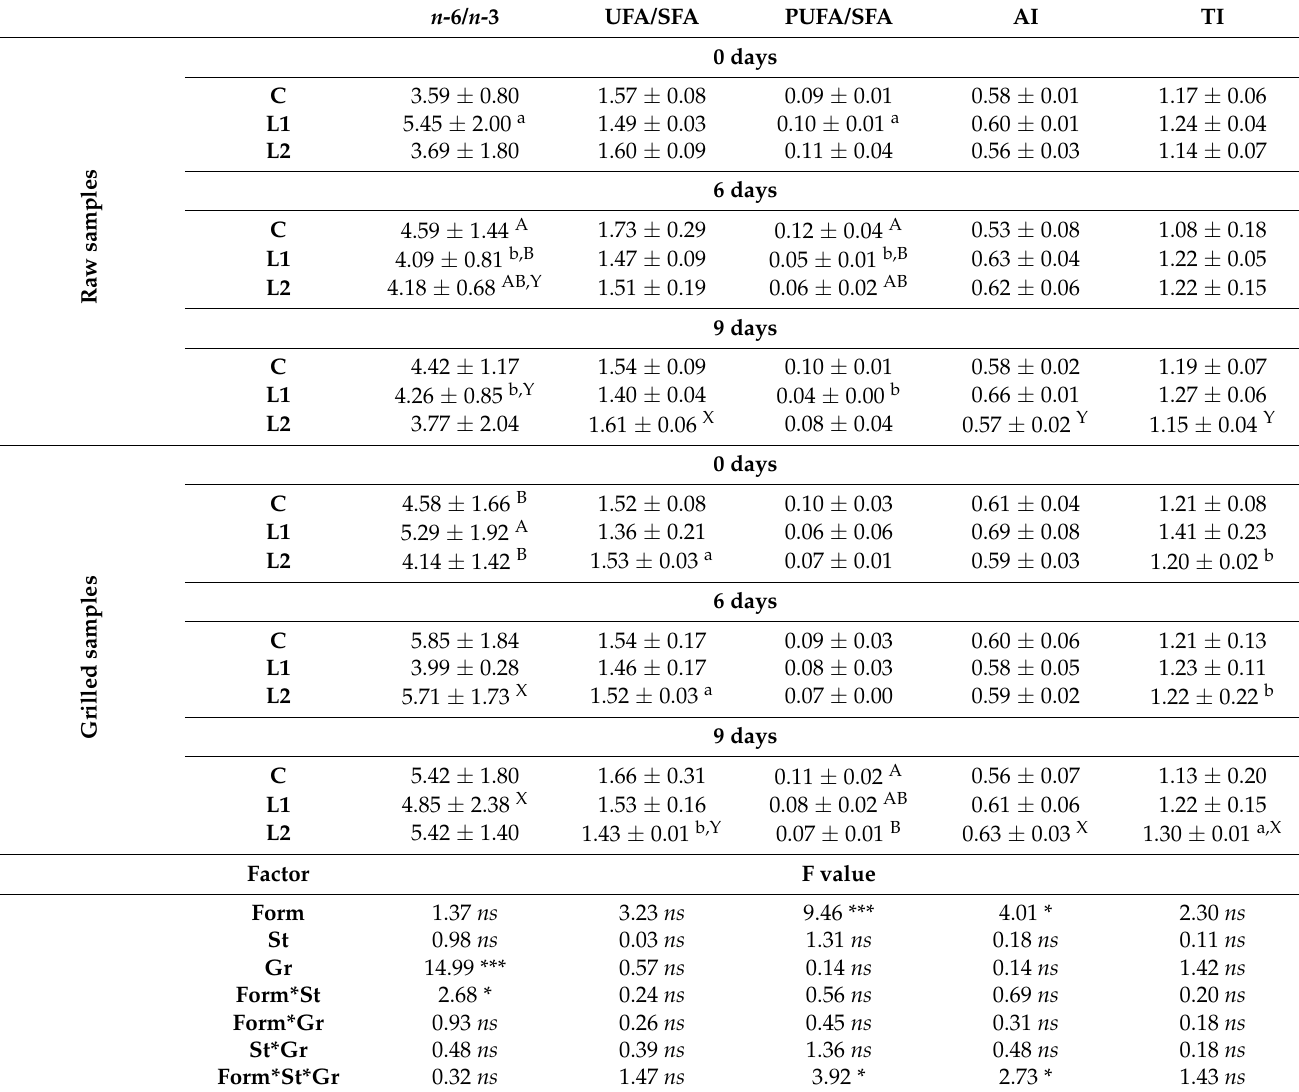
Table 5. Ratios of fatty acid classes, atherogenic index (AI) and thrombogenic index (TI) of raw and grilled hamburgers after 0, 6, and 9 days of storage. C, control (minced beef meat + maltodextrine + starter cultures); L1, minced beef meat +